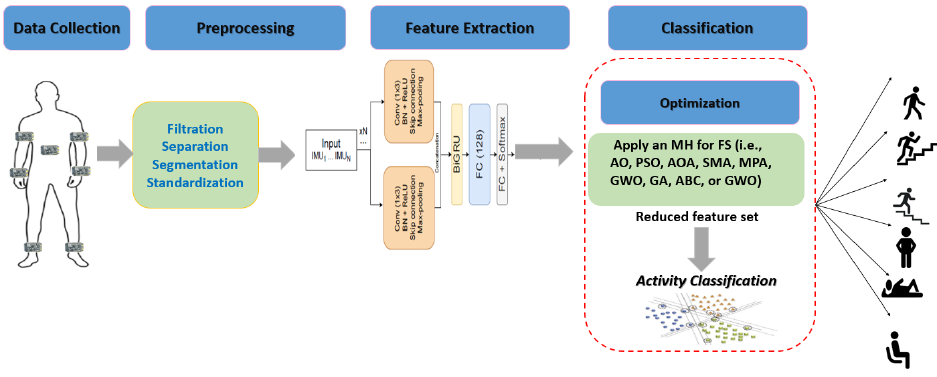
Figure 1. The main workflow of HAR application using the integration of deep learning and MH optimization algorithms.